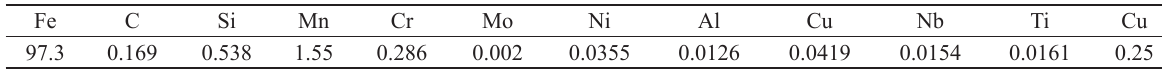
Table 2. Chemical composition of a pipe of the main gas pipeline “Kyiv–West of Ukraine-1” (Steel 17G1S)